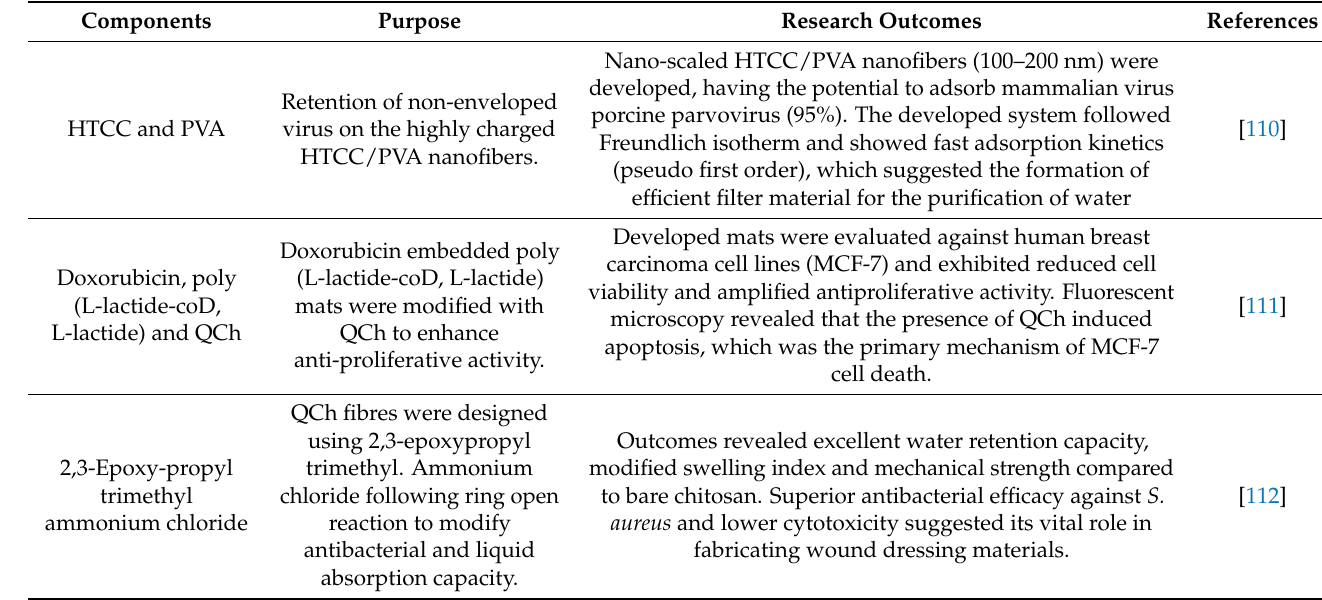
Table 3. Quaternized chitosan-embedded nanofibers in diverse biomedical arena.